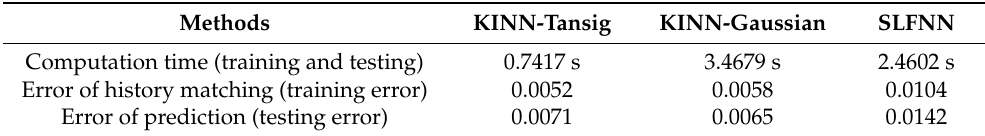
Table 4. The time consumption, training error (MSE) and testing error (MSE) of KINN-tansig, KINN-Gaussian and SLFNN in the braided river reservoir case.